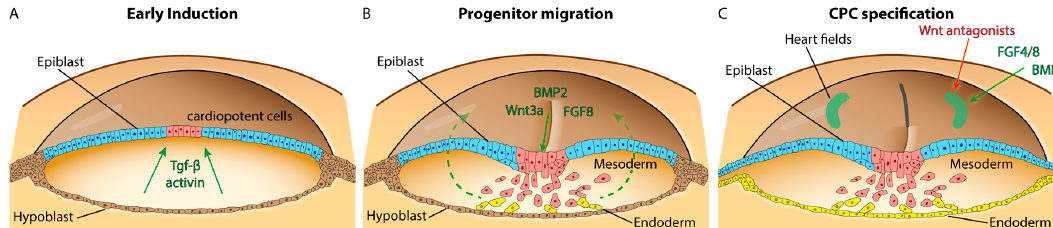
Figure 1. Cardiogenic signals in pre-gastrula, gastrula, and neurula stage embryos. Schematic representation of a pre-gastrula chick embryo ( A ) with epiblast and hypoblast layers. Cardiopotent cells identified in the posterior epiblast respond to Tgf- β /activin signaling. The diagram in ( B ) represents a HH3 gastrula with prospective mesoderm ( red ) and endoderm cells ( yellow ) ingressing through the primitive streak. Wnt3a, BMP2, and FGF8 are expressed in the primitive streak and control migration trajectories of cardiac progenitor cells, indicated by green stippled arrows, towards the bilateral heart fields. ( C ) Representation of a neurula stage embryo, approximately HH5. Gastrulation continues at the primitive streak, which is regressing; an endoderm layer has formed, and cardiogenic cells are located in bilateral heart fields in the anterior lateral plate mesoderm. A combination of BMP2, FGF4/8, and inhibitors of canonical Wnt signaling act to specify cardiac fate.